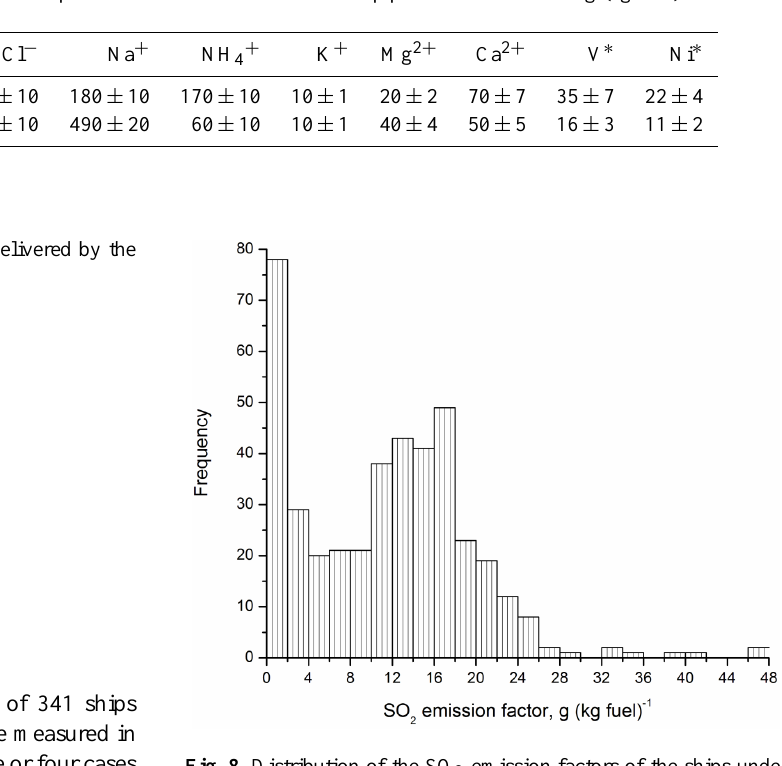
Fig. 8. Distribution of the SO 2 emission factors of the ships under Figure 8. Distribution of the SO 2 emission factors of the ships under study. The total 1003 study. The total SO 2 EF range was divided into 24 EF bins. Fre- SO 2 EF range was divided into 24 EF bins. Frequencies of the EF bins are plotted 1004 quencies of the EF bins are plotted along the along the y-axes. 1005